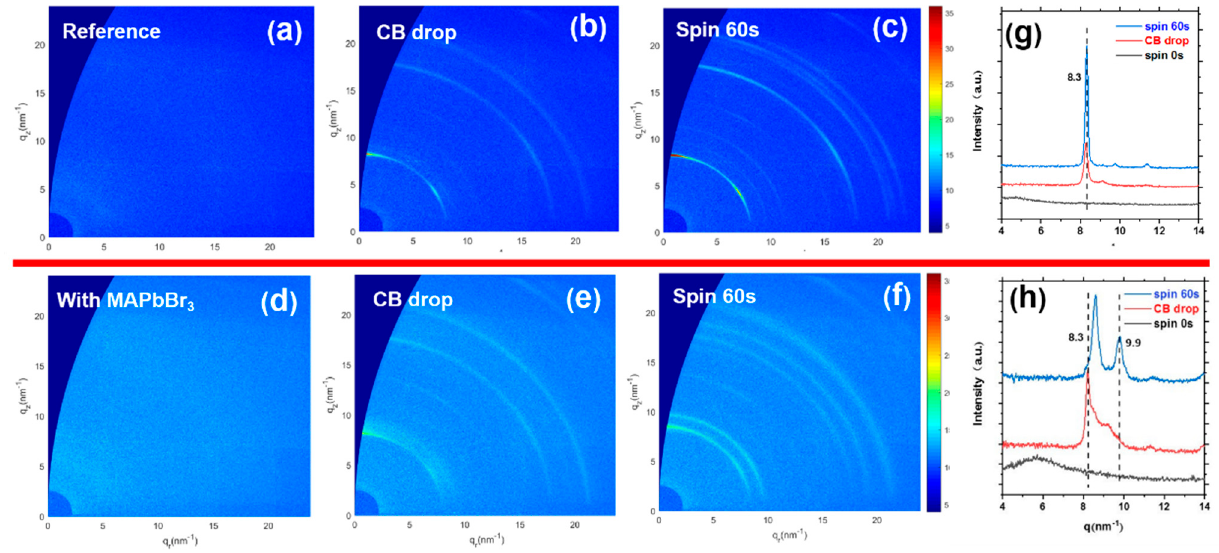
Figure 2. The 2D GIWAXS patterns taken at different times during spin-coating for an undoped film in ( a – c ) and for a MAPbBr 3 -doped perovskite film in ( d – f ), respectively. The derived 1D XRD spectra for the undoped film in ( g ) and for the MAPbBr 3 -doped perovskite film in ( h ), respectively.